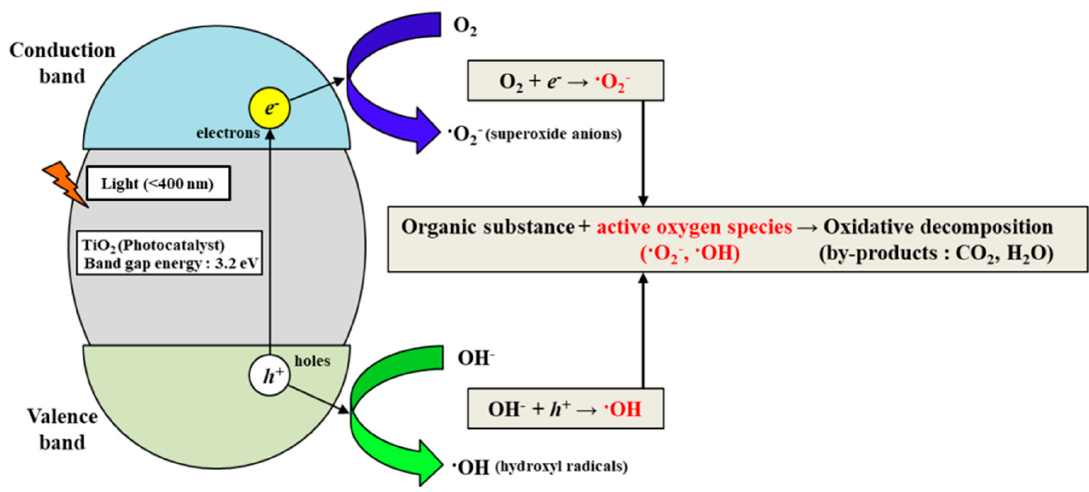
Figure 3. Mechanism of water pollutants’ decomposition utilizing photocatalyst (TiO 2 ).